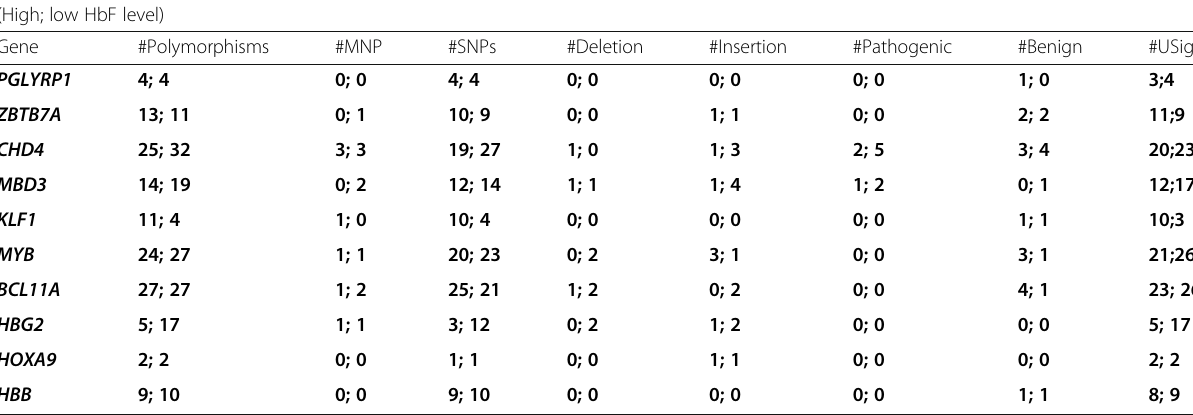
Table 2 Characterization of polymorphisms within mutant and modifiers genes in SCA patients from Tanzania. Details of gene variants can be found in Supplementary File: Table S1